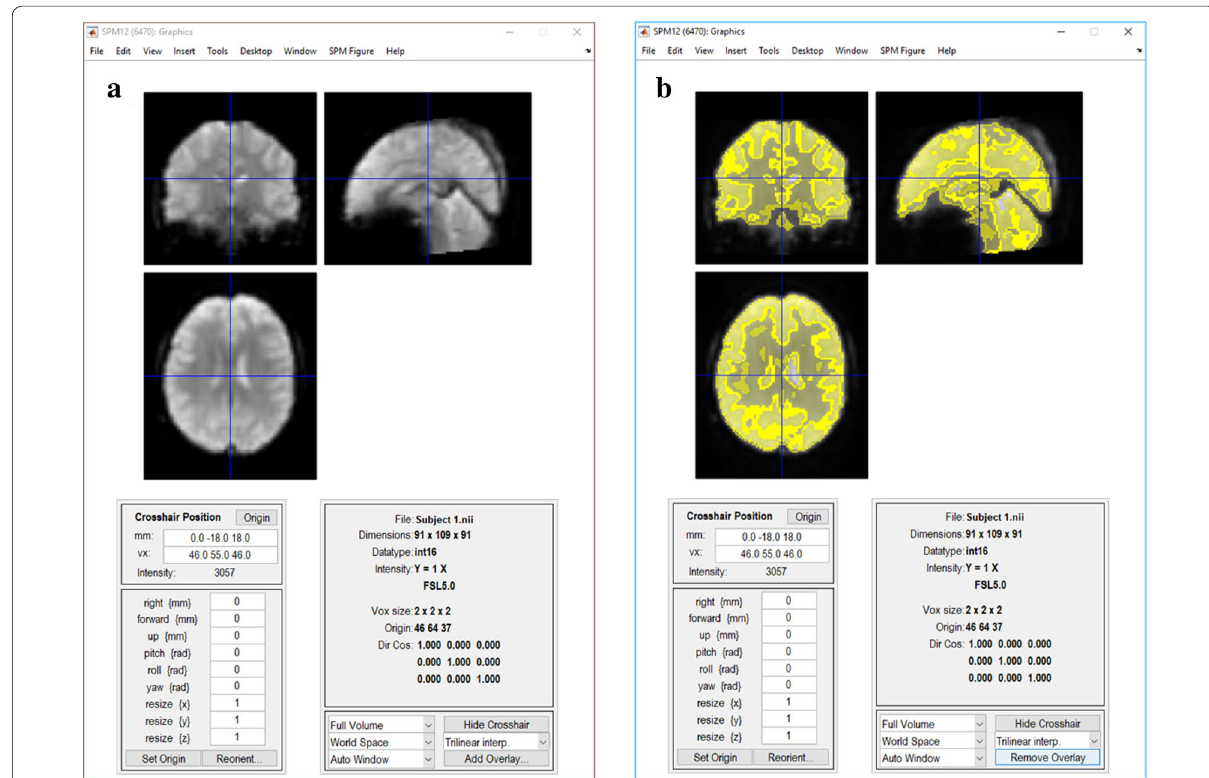
Fig. 3 An example of an fMRI visualisation using SPM [71] showing the results of white matter (WM), grey matter (GM) and cerebrospinal fluid (CSF) after segmentation with FSL FAST [70]: a the original fMRI image with a voxel size of 2 matter types overlaid in shades of yellow (WM in the dark yellow; GM in the middle yellow; CSF in the bright